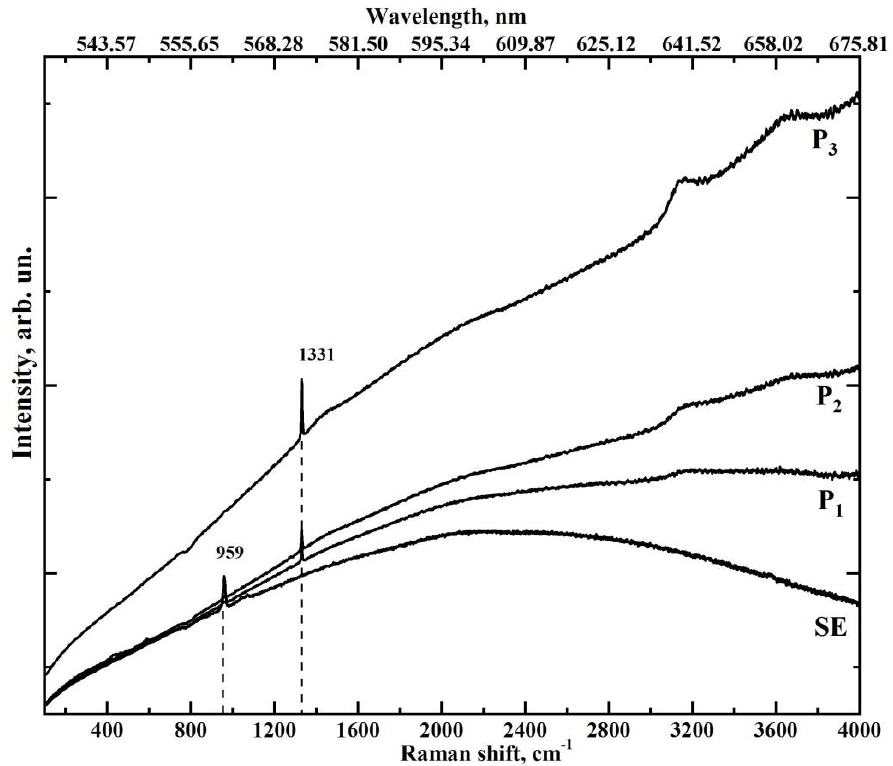
Figure 5. Results of microRaman spectroscopy of the different microregions of sample E (demineralisation of the lateral wall of the fissure, incipient caries in the fissure, ICDAS 1) obtained with the use of the automated motorised double-axis stage.